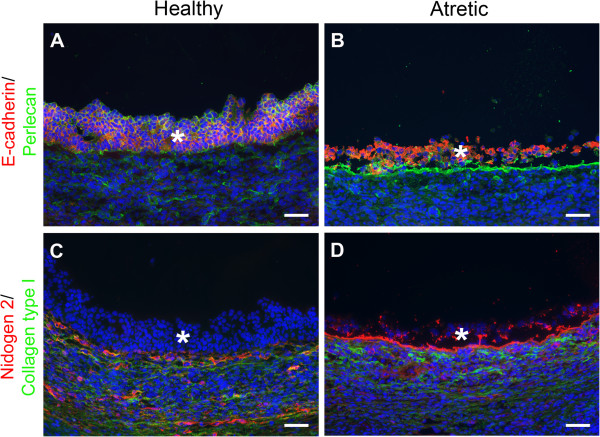
Localisation of E-cadherin, perlecan, nidogen 2 and collagen type I in small healthy and atretic follicles. (A, B) E-cadherin (red) is restricted to the membrana granulosa and is strongly expressed in atretic follicles. Perlecan (green) marks the follicular and sub-endothelial basal lamina and is expressed in the cytoplasm of granulosa cells of healthy and atretic follicles. (C, D) Nidogen-2 (red) is localised to the basal lamina of both follicle types, but is only expressed in the granulosa layer of small atretic follicles. Collagen type I (green) is not localised to the granulosa cells. It is restricted to the thecal and medullar stroma. The star indicates the granulosa layer. Bar = 50 μm.